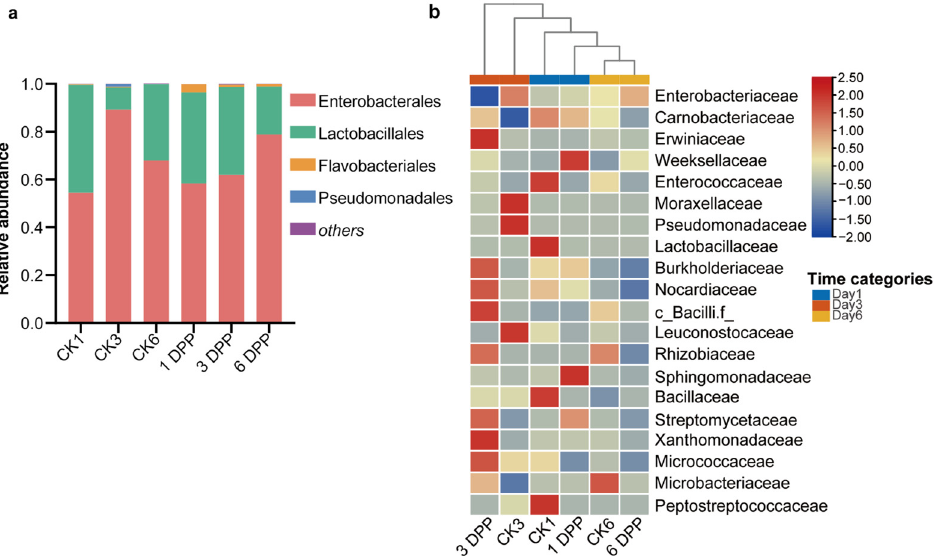
Figure 4. Impact of parasitization on the composition of host-gut bacterial community. ( a ) Relative abundance in the host-gut microbiome at the order level. “Others” included < 1% relative abundance taxa. ( b ) Heatmap of the family abundance in the P. xylostella gut microbiome in different time categories. Columns were clustered using the average method based on Euclidean distance, and rows were normalized.